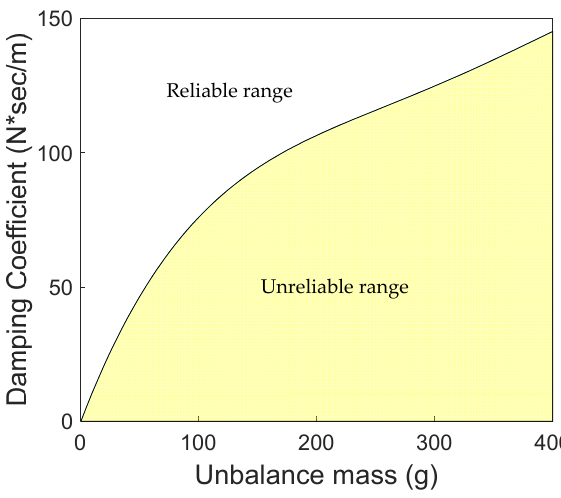
Figure 12. Reliability diagram of the linear analytical model.